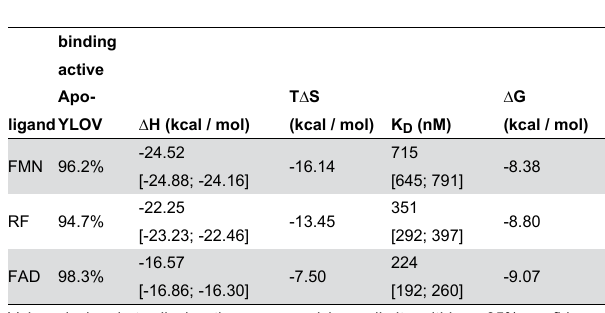
Values in brackets display the upper and lower limits within a 95% confidence interval.